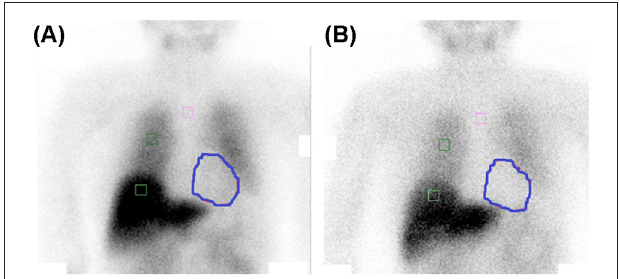
FIGURE 2 | Myocardial accumulation of metaiodobenzylguanidine (123I-MIBG) is low [H/M = early: 1.72 (A) , delayed: 1.34 (B) ]. The circled areas indicate